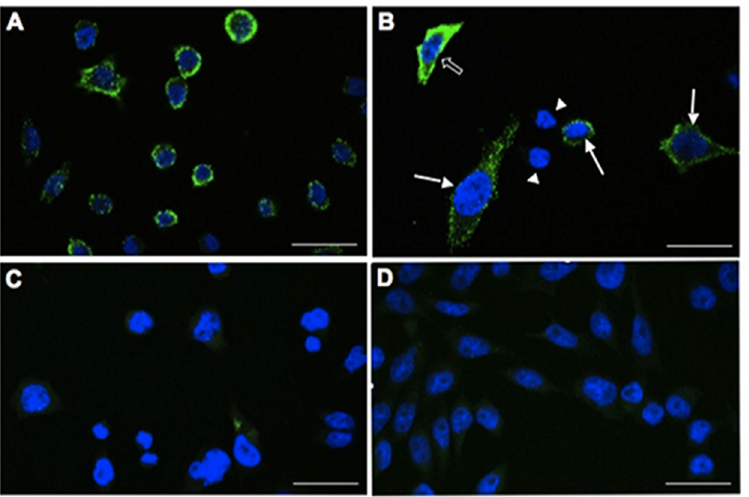
Fig 1. RNAscope with aplnr probes in CHO-B78 (rat APJ) and non-transfected CHO cell cultures. In (A) clear, punctate aplnr labellingis present in the cytoplasm of the majority of CHO-B78 cells with cell-cell variabilityin the levels of expression. Strongly (open arrow), moderately (arrows) and unlabelled(arrowheads) aplnr cells in CHO-B78 cultures are shown in ( B ). (C) shows negativecontrol probe on CHO-B78 cells, while the lack of aplnr labellingin non-transfected CHO cells is shown in (D) . Scale bar = 25 μ